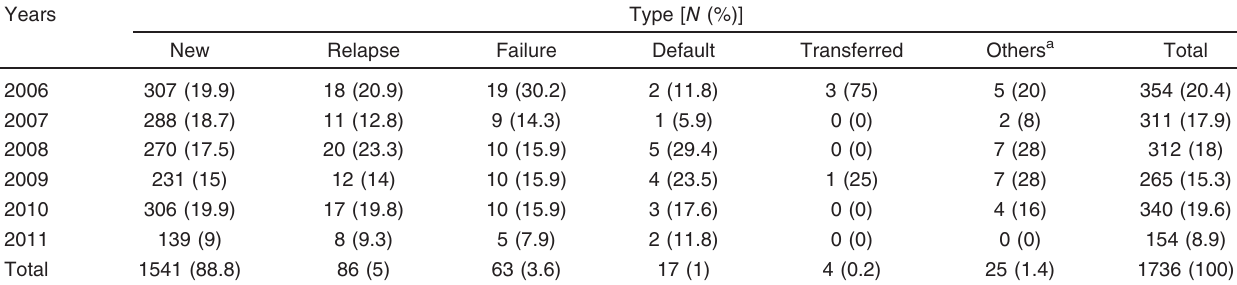
Table 4 Distribution of total tuberculous cases according to the type of patient on the basis of the history of previous treatment Years